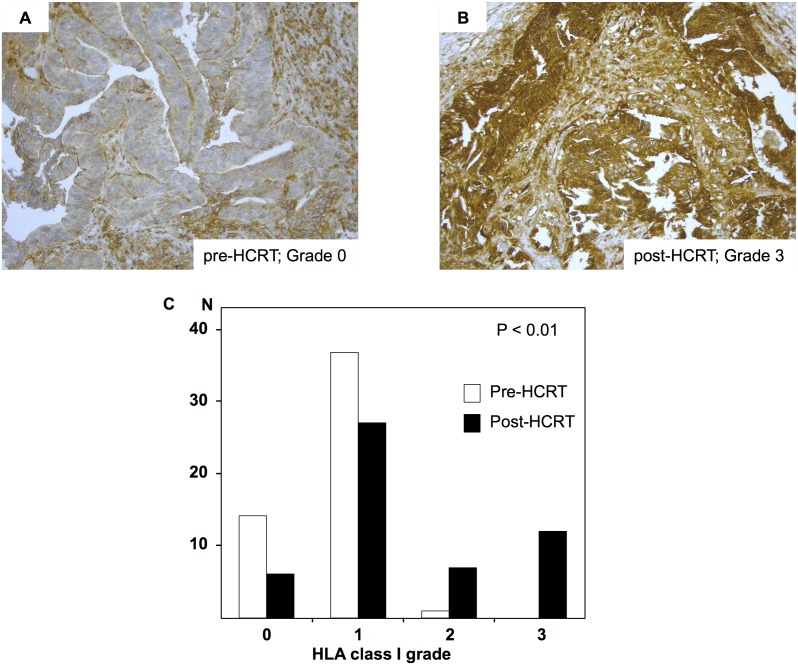
Changes in Human leukocyte antigen (HLA) class I expression after preoperative hyperthermo-chemoradiotherapy (HCRT).Grades of HLA class I expression in samples from the same patient. A, pre-HCRT specimen; Grade 0. B, post-HCRT specimen; Grade 3. Magnification, ×200. C, HLA class I expression in pre- and post-HCRT specimens. Predictive value was tested using the Wilcoxon signed rank test.